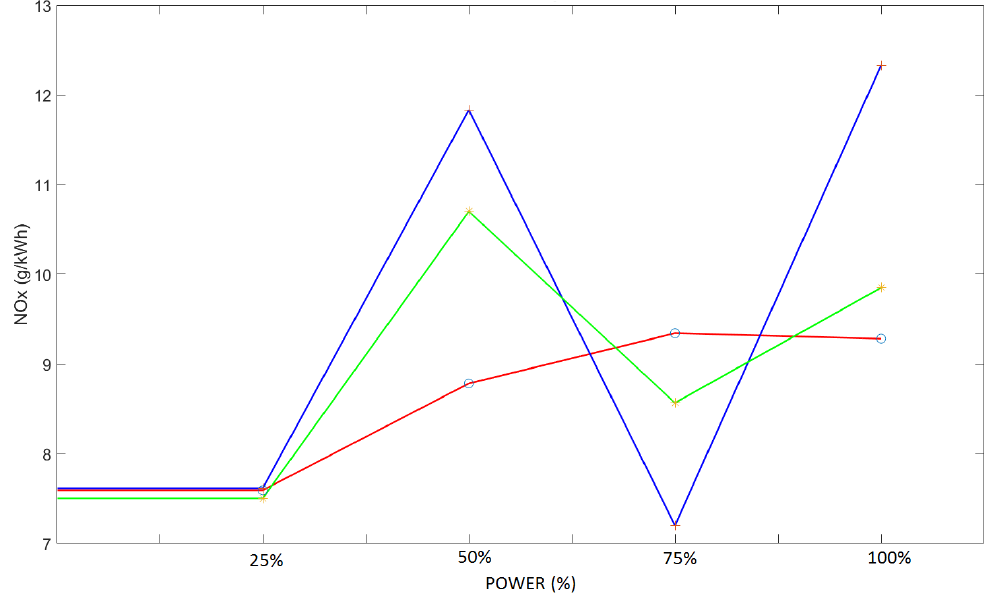
Figure 4. Three different NO x lines of three different engine